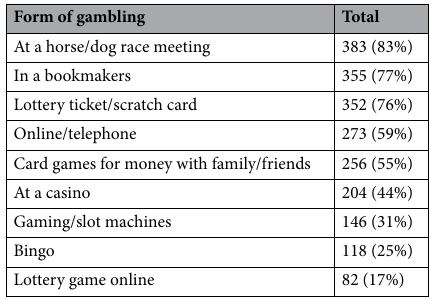
Table 3. Forms of gambling within the past year amongst current